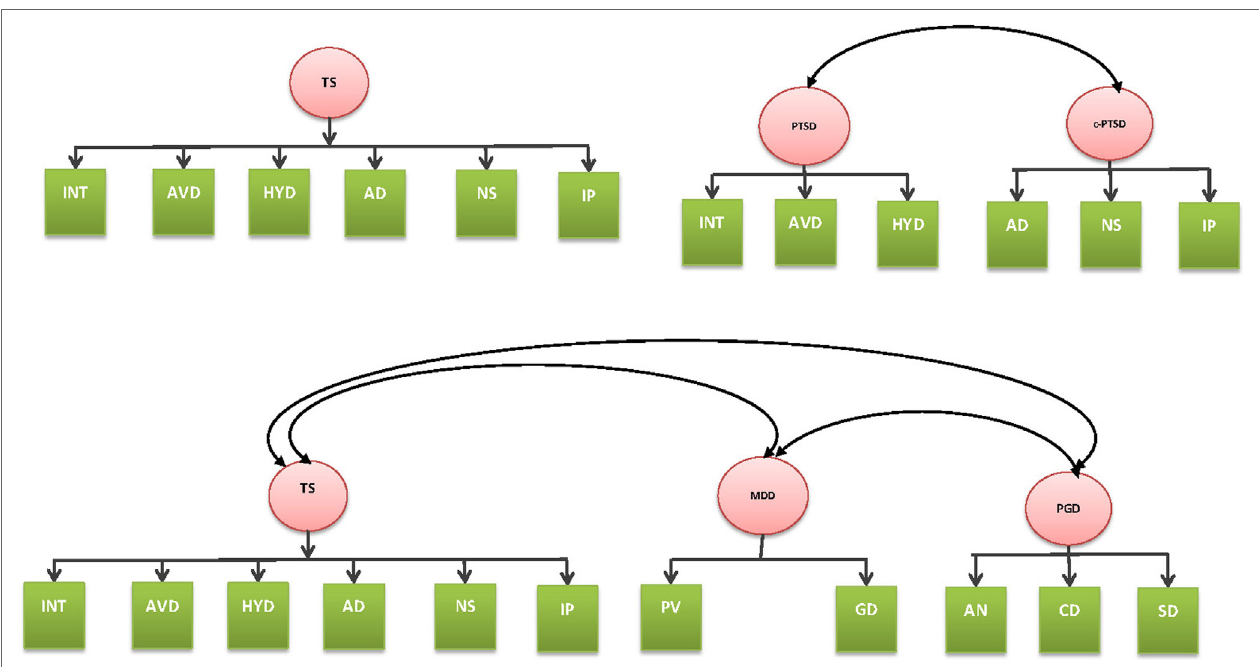
FigUre 1 | One-factor and two-factor models of complex post-traumatic stress disorder (c-PTsD) and post-traumatic stress disorder (top) . Three-factor model of C-PTSD, major depressive disorder, and complex grief